Question: Which visualization type does this figure use?
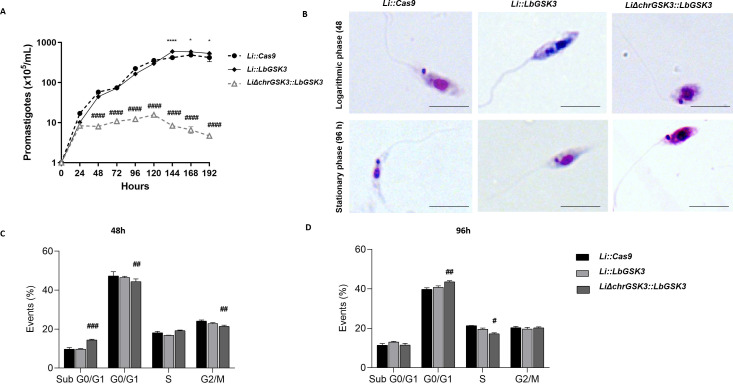
Answer: bar